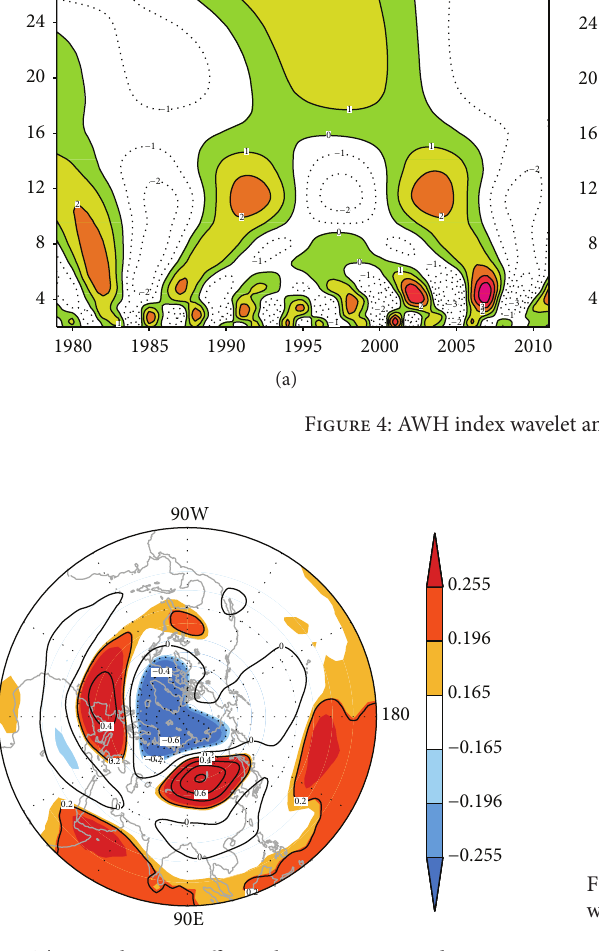
Figure 5: The correlation coefficient between AWH and geopoten- tial field at 500hPa level.